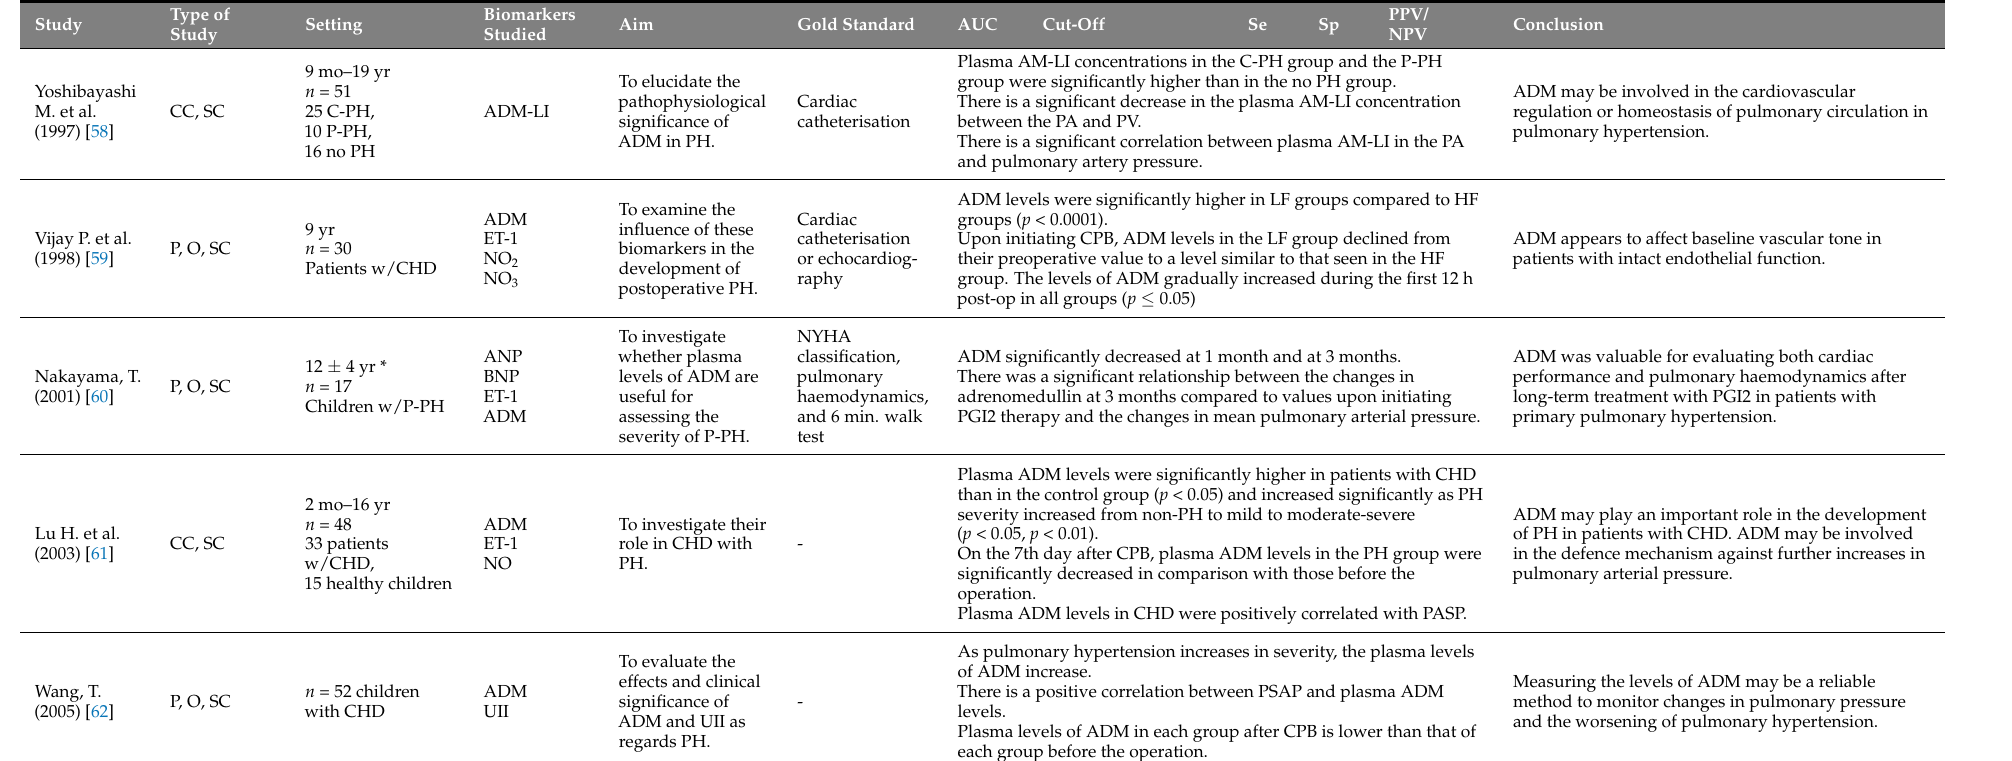
Table 3. Adrenomedullin and pulmonary